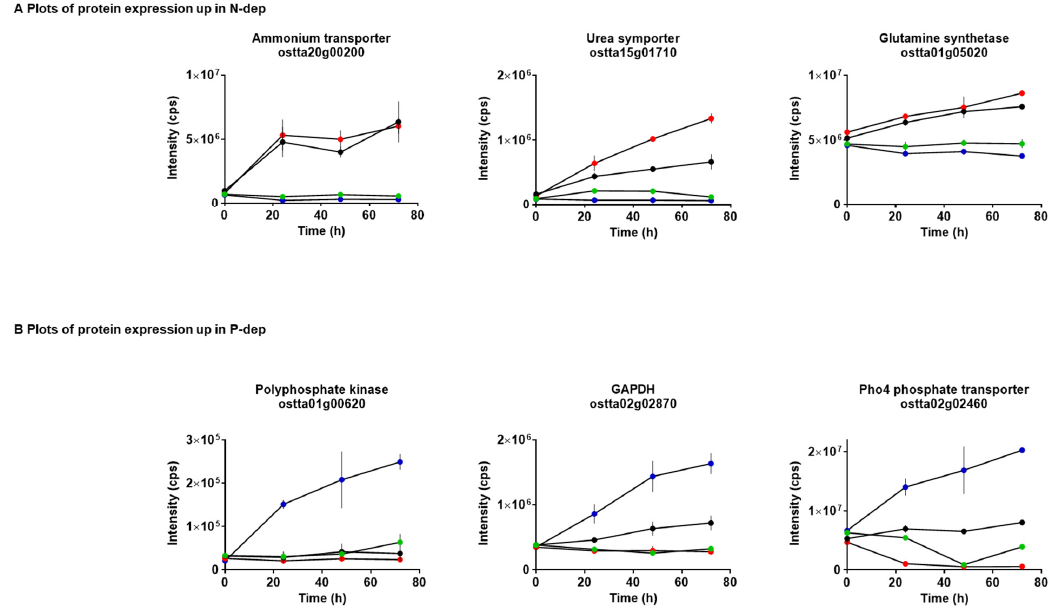
Figure 2. Temporal increases in protein expression in O. tauri cultured under N-dep or P-dep conditions. The expression of proteins associated with ( A ) nitrogen metabolism and ( B ) phosphate scavenging was elevated over 72 h. Key: Complete media = green; N-dep = red; P-dep = blue; NP-dep =